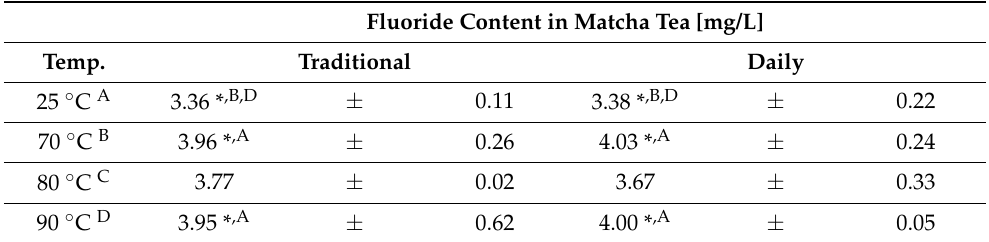
Table 2. The fluoride content in tea matcha (traditional, daily) prepared at various temperatures. * FDR p < 0.05 between the types of matcha (traditional, daily) prepared at various temperatures. Fluoride Content in Matcha Tea [mg/L]